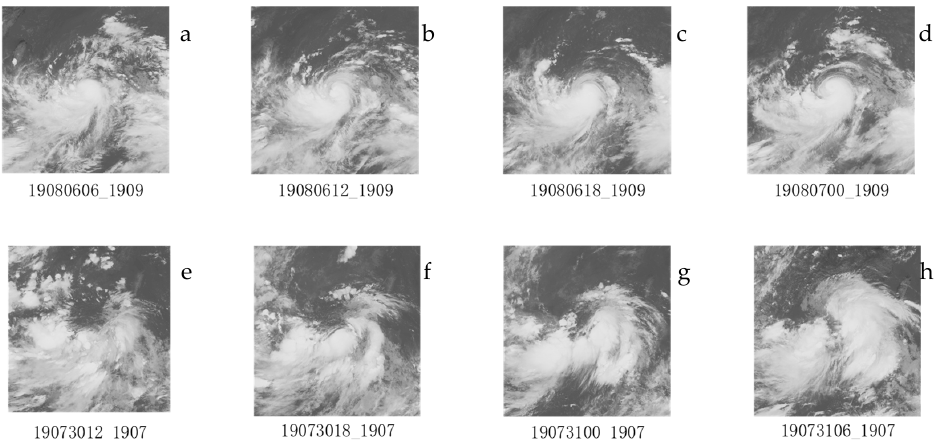
Figure 5. Satellite remote sensing cloud images of No. 1909 Typhoon LEKIMA ( a . 06:00 UTC on 6, b . 12:00 UTC on 6, c . 18:00 UTC on 6, d . 00:00 UTC on 7) August 2019 and cloud images of No. 1907 Typhoon Wipha ( e . 12:00 UTC on 30, f . 18:00 UTC on 30, g . 00:00 UTC on 31, h . 06:00 UTC on 30) July 2019.